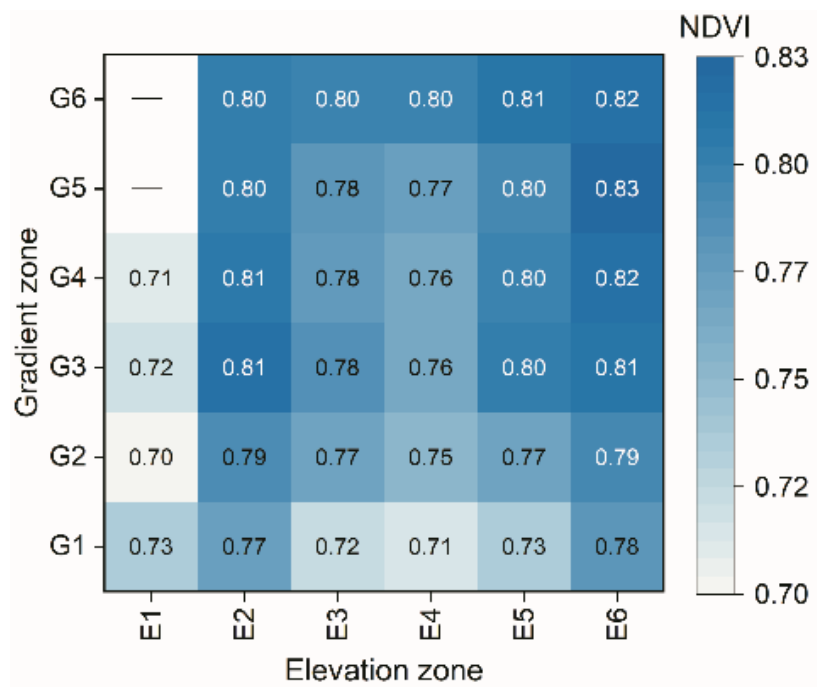
Figure 4. Heat map of the average the NDVI with elevation and slope from 1982 to 2020 in the UWNR.